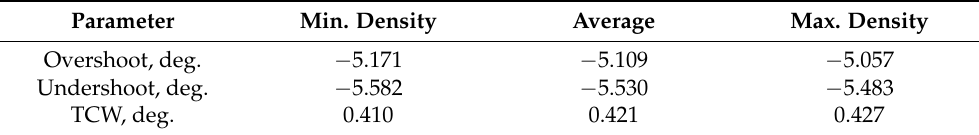
Table 9. Effect of density variations on Venus aerocapture